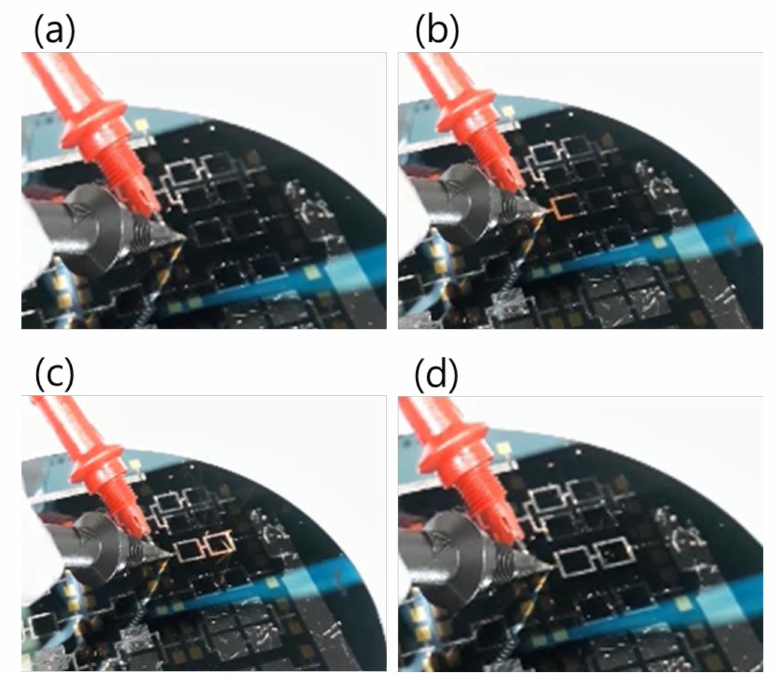
Figure 16. Images showing reaction front propagation steps across a patterned Pd/Al-Ni/Al MS- iRMS of squared frames grown on a SiO 2 /Si-wafer. ( a ) Initiation step; ( b , c ) Self-maintained propa- gating reaction steps; ( d ) Reaction product morphology after the reaction